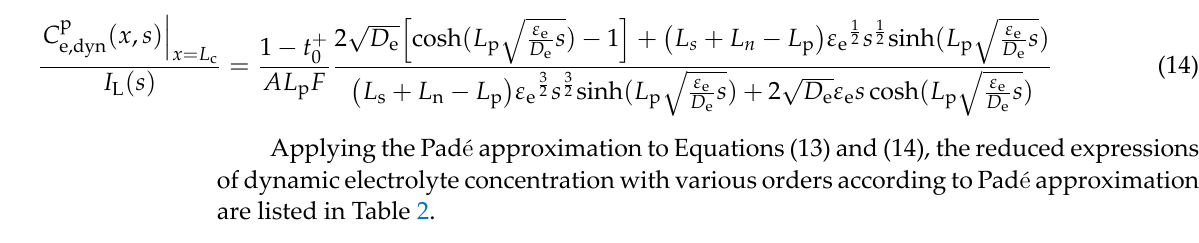
Table 2. Pad é approximation results of dynamic electrolyte concentrations with different orders. Dynamic Electrolyte Concentration Expressions C e,dyn ( x , s ) / I L ( s